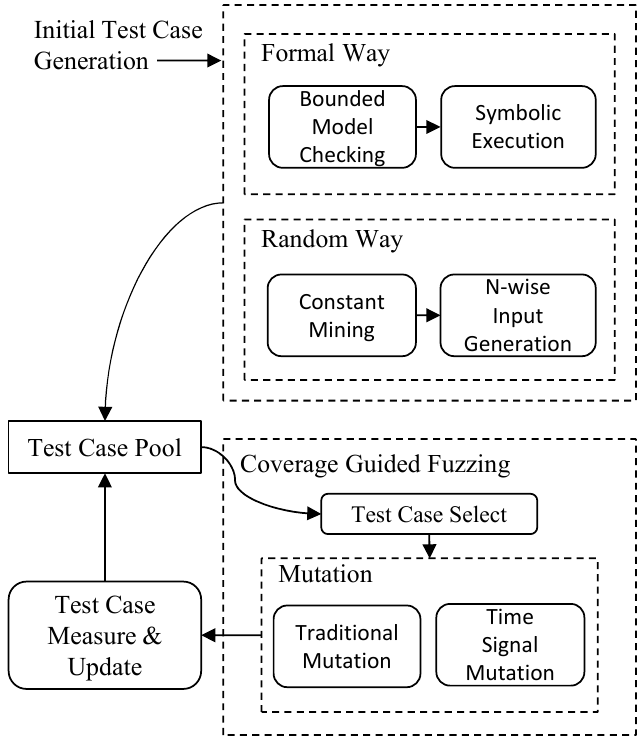
Figure 3. Components of modules in workflow